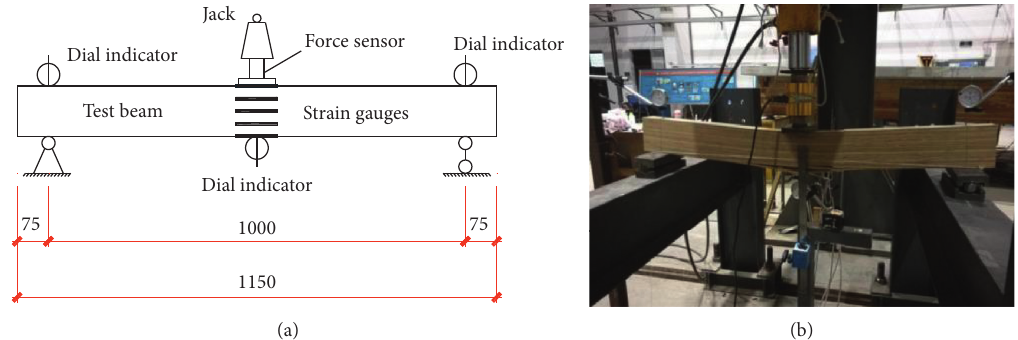
Figure 2: Test apparatus loading with one-point. (a) Loading schematic diagram. (b) Testing field.